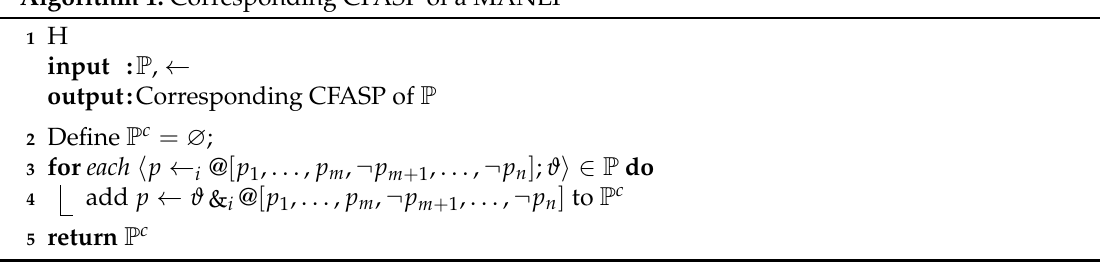
Algorithm 1: Corresponding CFASP of a